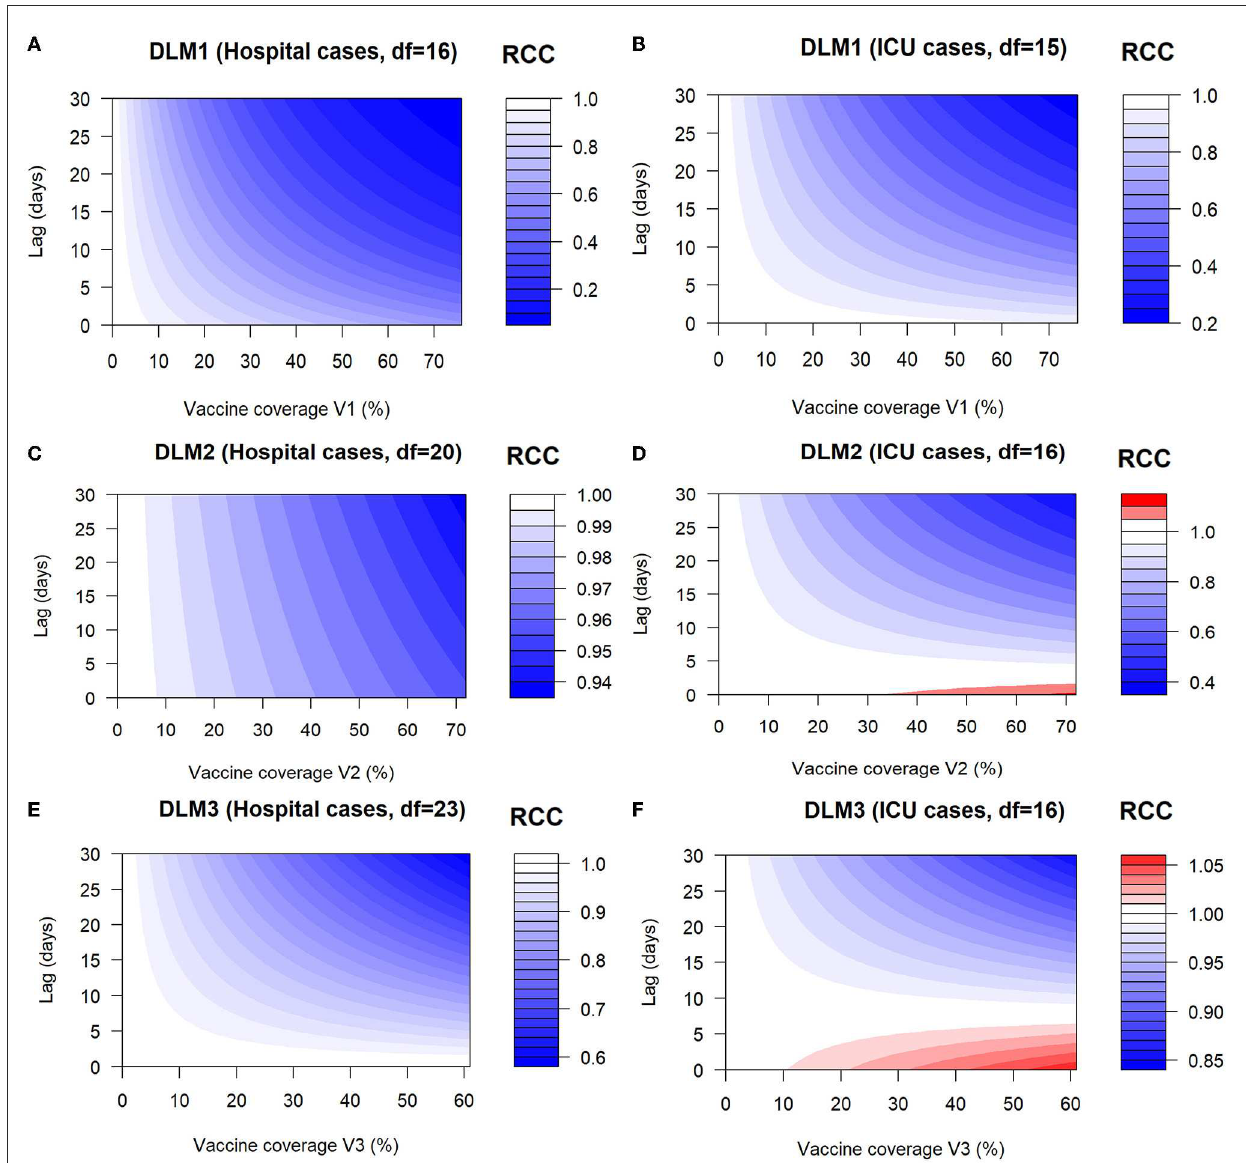
FIGURE2 Contour plots of the combined effects of lag times and vaccinations on the relative count change (RCC) of hospital and ICU cases. (A) Contour plot of RCC of hospital cases as a function of V 1 and lag times. (B) Contour plot of RCC of ICU cases as a function of V 1 and lag times. (C) Contour plot of RCC of hospital cases as a function of V 2 and lag times. (D) Contour plot of RCC of ICU cases as a function of V 2 and lag times. (E) Contour plot of RCC of hospital cases as a function of V 3 and lag times. (F) Contour plot of RCC of ICU cases as a function of V 3 and lag times. DLM1, DLM2, and DLM3 represent the distributed lag models for the first, second and third